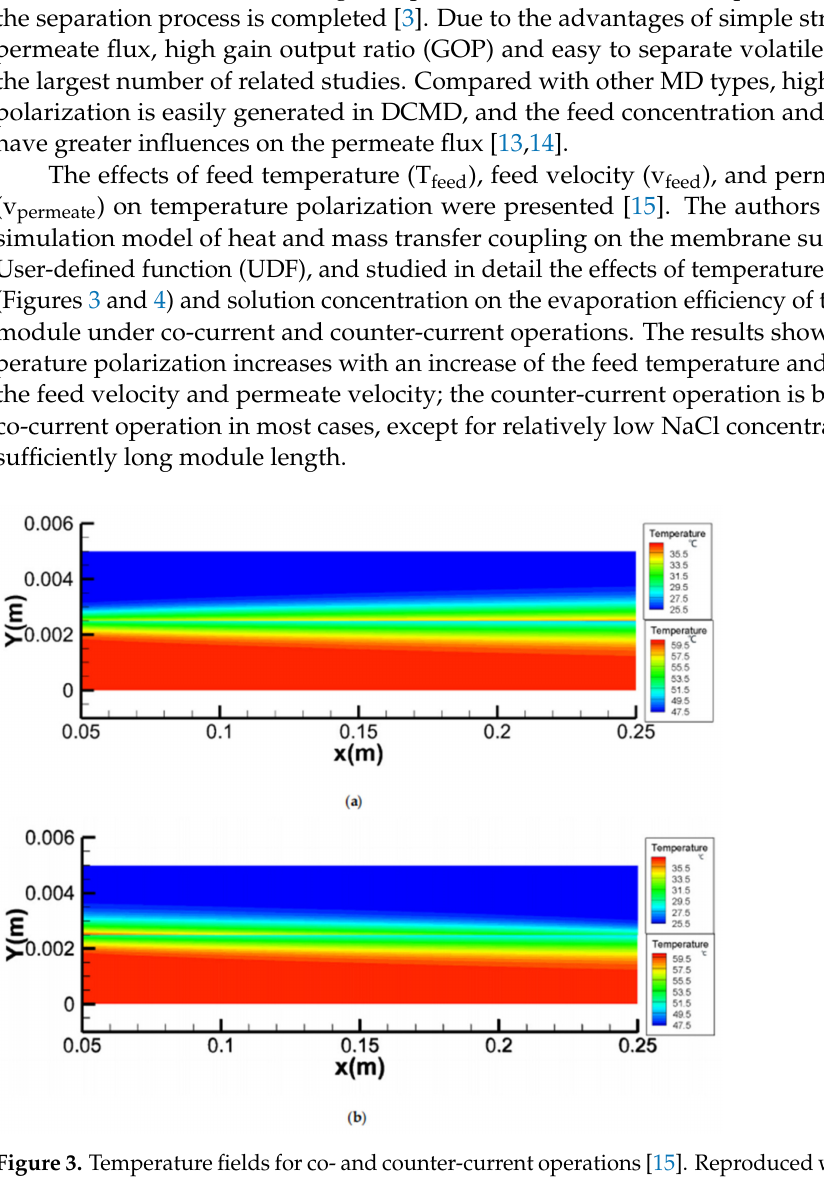
Figure 3. Temperature fields for co- and counter-current operations [15]. Reproduced with permission from MDPI, 2020. Different color scales were used in the permeate and feed channels, T feed = 60 ◦ C, T permeate = 25 ◦ C, v feed = v permeate = 0.15 m/s, concentration of feed = 24.2 wt.%) ( a ) co-current operation; ( b ) counter-current